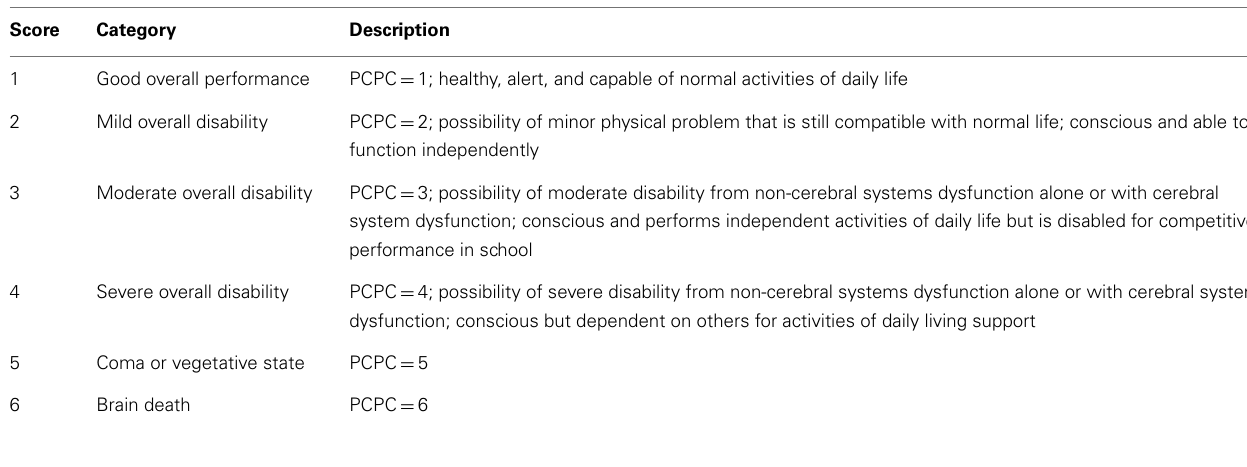
Table 2 | Pediatric overall performance category